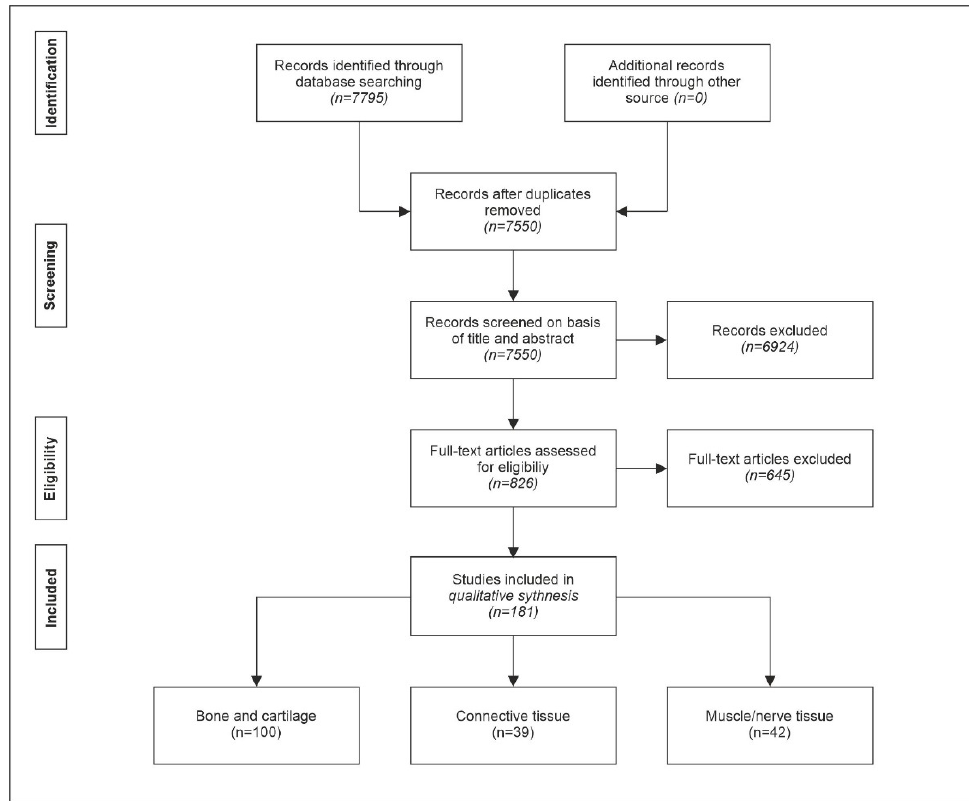
Figure 1. Systematic review flowchart of the literature search regarding studies on the effects of exposure of musculoskeletal tissue to extracorporeal shock waves performed according to the PRISMA guidelines [198] on 30 September 2021. PRISMA guidelines [198] on 30 September 2021.